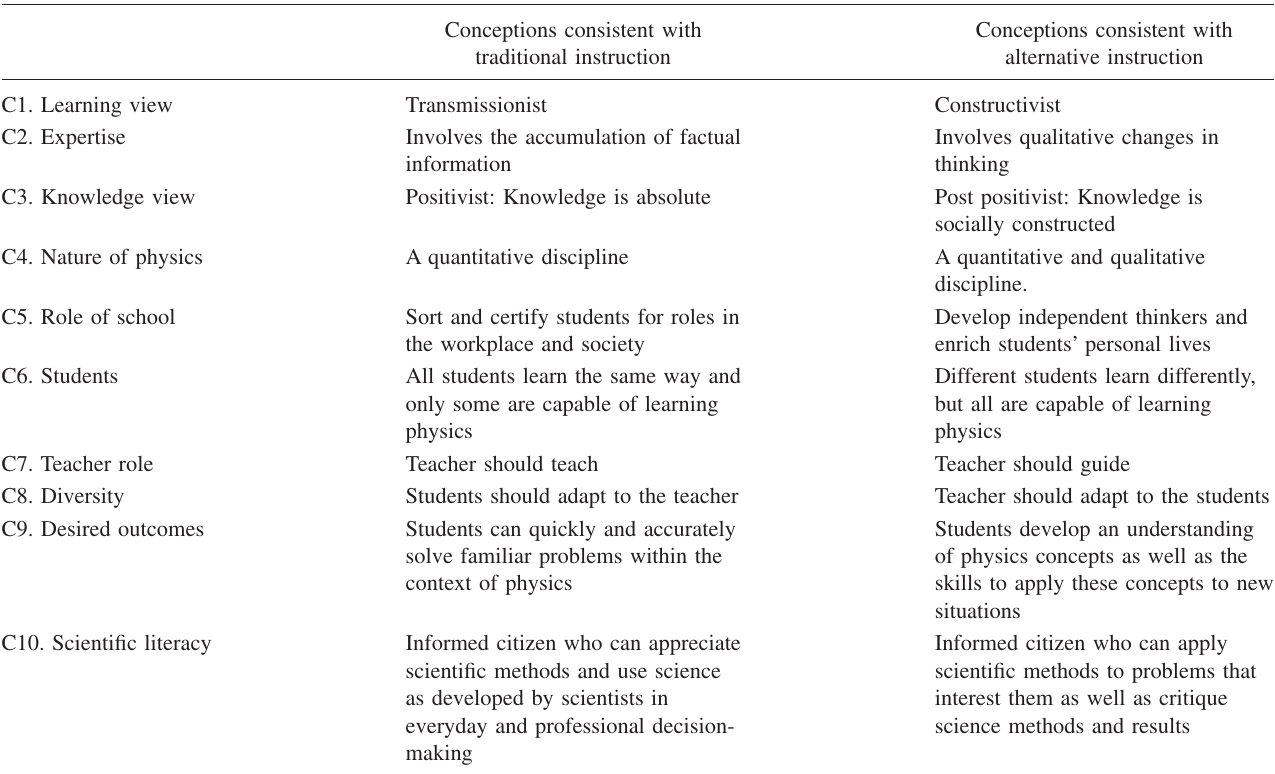
TABLE II. Main categories of